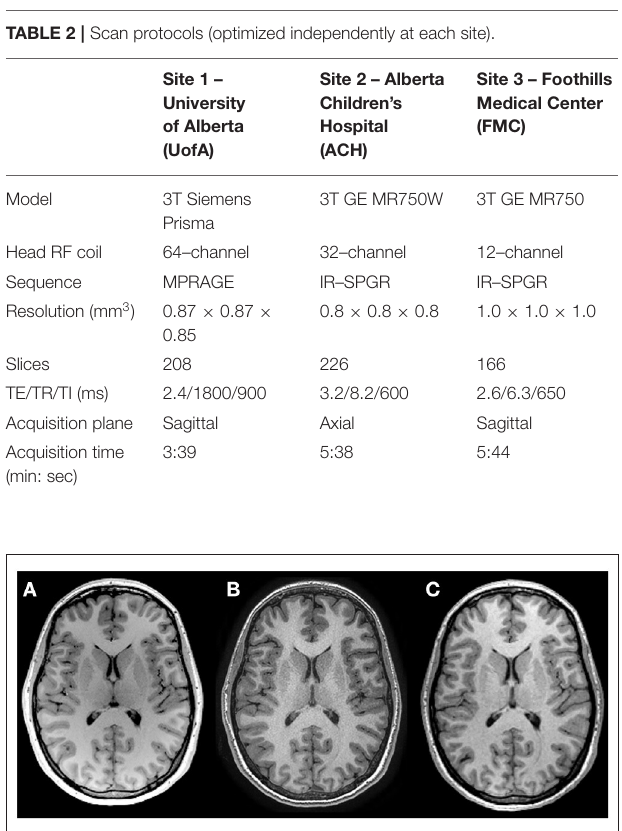
FIGURE 1 | T1 weighted images of the same 27–year–old female scanned at (A) Site 1 University of Alberta, (B) Site 2 Alberta Children’s Hospital and (C) Site 3 Foothills Medical Center, using non–harmonized protocols. See Table 2 for acquisition protocols.